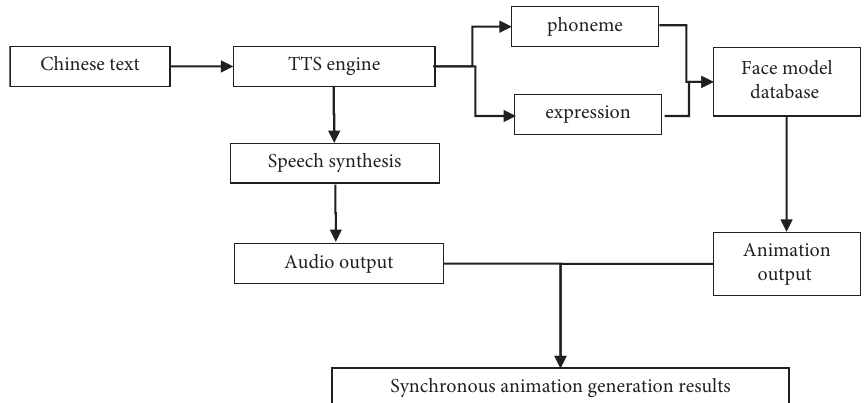
Figure 4: Flowchart of the lip sync system for the Chinese voice synchronization.